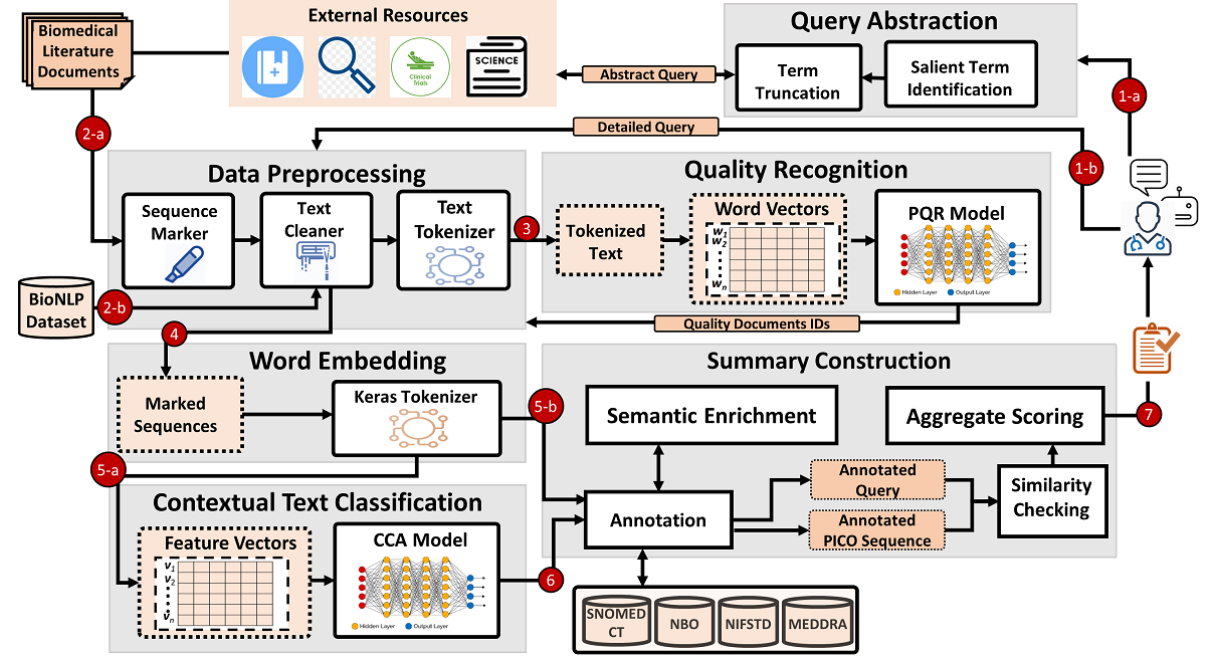
Figure 1. Proposed Biomed-Summarizer architecture with four major components: data preprocessing, quality recognition, context identification, and summary construction. PQR: prognosis quality recognition; CCA: clinical context-aware; PICO: Population/Problem, Intervention, Comparison,